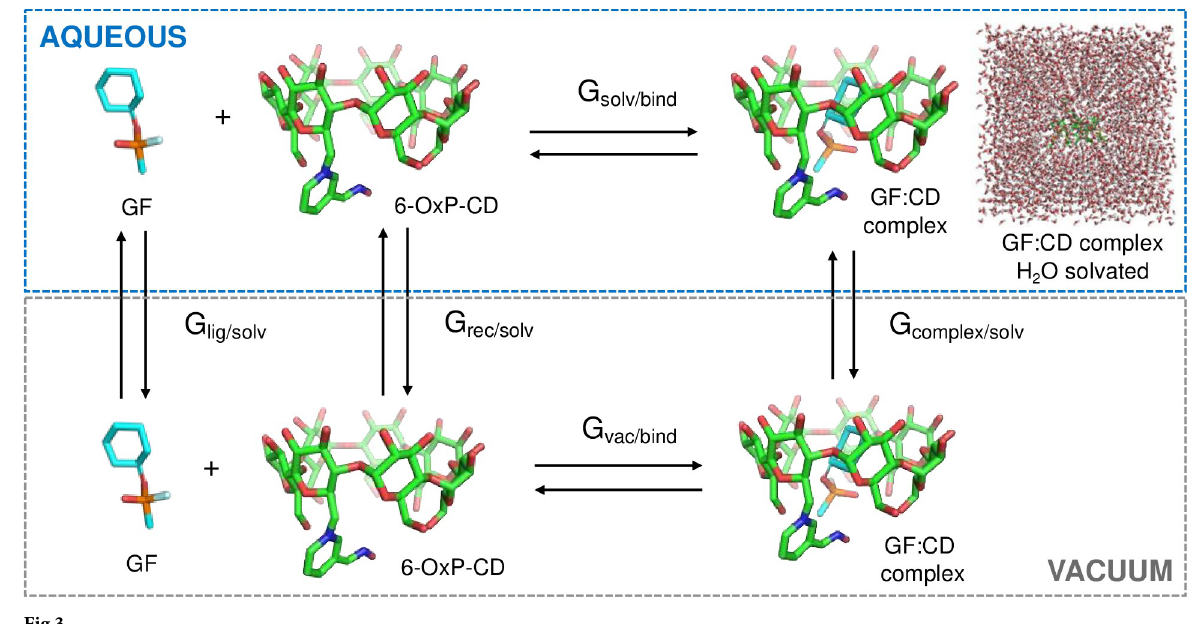
Fig 3. the solvation energy, ¼ E þ G G total gas sol The contribution of entropy (S) was neglected during these free energy calculations. The solvation free energy (G ) is the sum of the polar and nonpolar solvation energies of the mol- sol ecules determined by solving the Generalized Born (GB) equation. The binding free energies for the complexes were calculated using the MMPBSA.py script [59] in AMBER12 on snap- shots from each 7.5 ns trajectory. The modified Onufriev-Bashford-Case-I GB (ib = 2) model [60, 61] was used for the calculation with a NA concentration of 0.24 mM. The surface tension